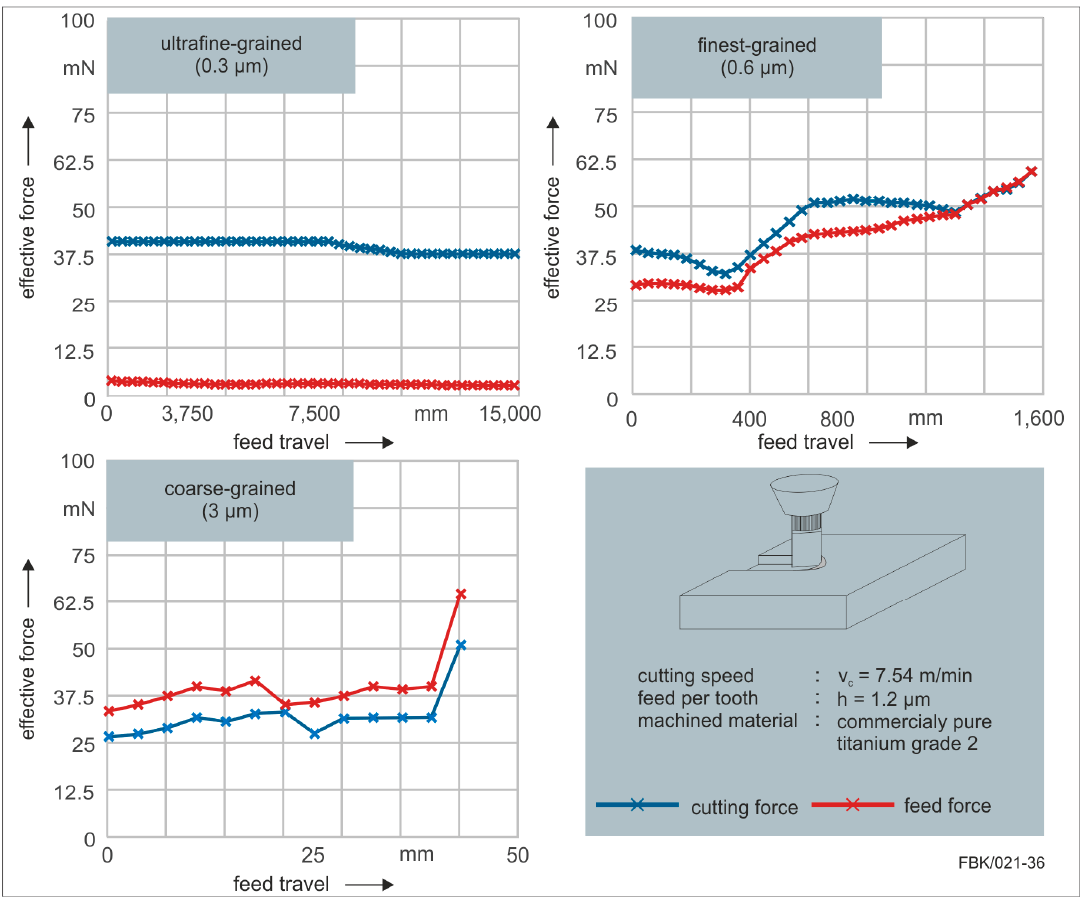
Figure 13. Forces in dependence of the cemented carbide specifications (top left: 0.3µm, top right: 0.6 mm and 3 mm (bottom left) when micro milling (process specifications bottom right). Micromachines 2017 , 8 , 261 16 of 18